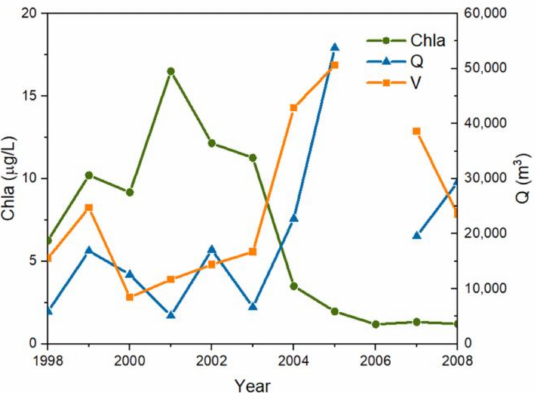
Figure 4. Chlorophyll a (Chl a ) response to hydraulic factors in the Chaihe Reservoir (1996–2021). Q is the quantity of outflow (m 3 ); V is the volume of the Chaihe Reservior (m 3 ).